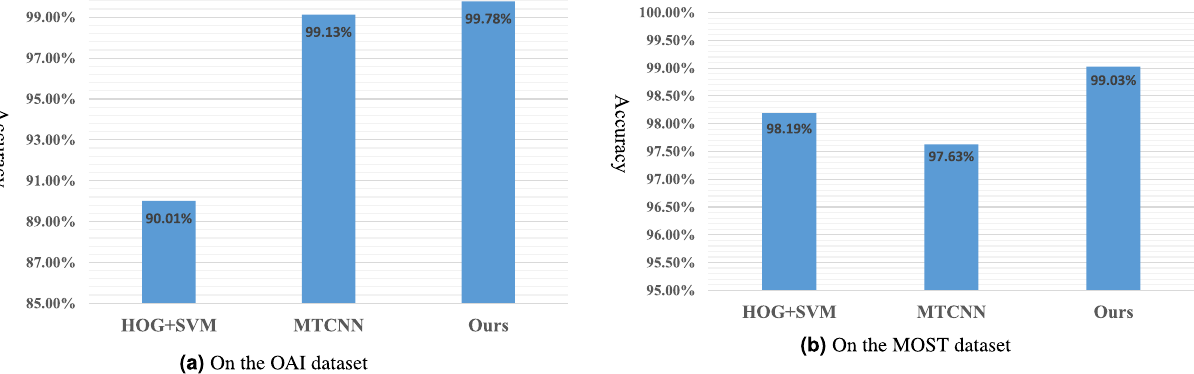
Figure 3. The detection accuracy comparison of knee joints with different methods on the OAI and MOST